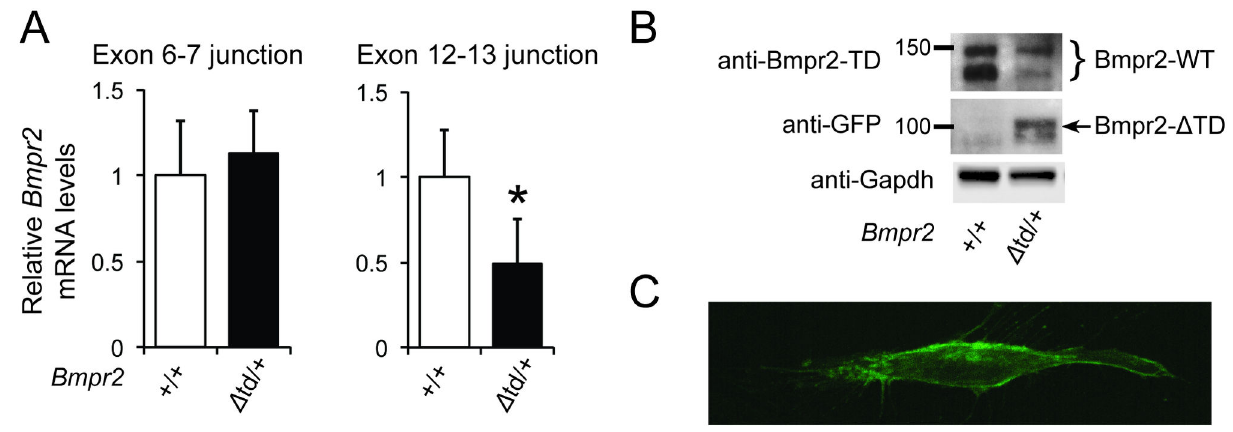
Figure 1. Bmpr2 expression in PaSMCs obtained from WT or Bmpr2 Δtd/+ mice. (A) Levels of Bmpr2 mRNA were measured in WT (Bmpr2 +/+ ) or Bmpr2 Δtd/+ PaSMCs by qPCR using hydrolysis probes for Bmpr2 exon junctions 6–7 and 12–13. Bmpr2 mRNA levels were normalized to Gapdh and expressed as the fold-change relative to Bmpr2 +/+ PaSMCs. *P < 0.01 compared to Bmpr2 +/+ PaSMCs. (B) Immunoblots prepared from lysates of Bmpr2 +/+ and Bmpr2 Δtd/+ PaSMCs were incubated with an antibody directed against the tail domain of Bmpr2 to detect Bmpr2 ‑ WT or with an anti-GFP antibody to detect Bmpr2 ‑ ΔTD. Immunoblots were subsequently incubated with an antibody directed against Gapdh as a control for protein loading. (C) Confocal microscopy image of localization of Bmpr2 ‑ ΔTD at the cell